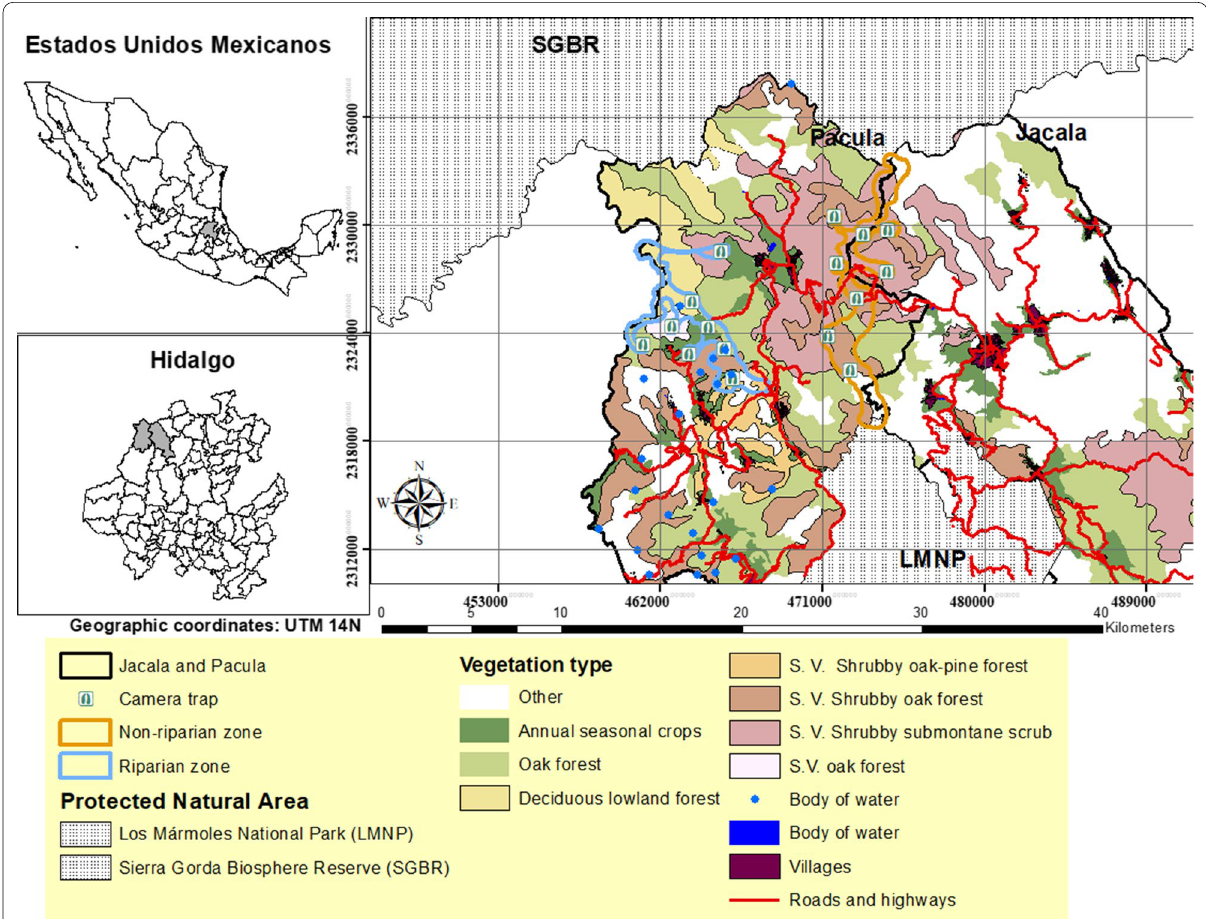
Fig. 2 Locations of camera traps in the municipalities of Pacula and Jacala,